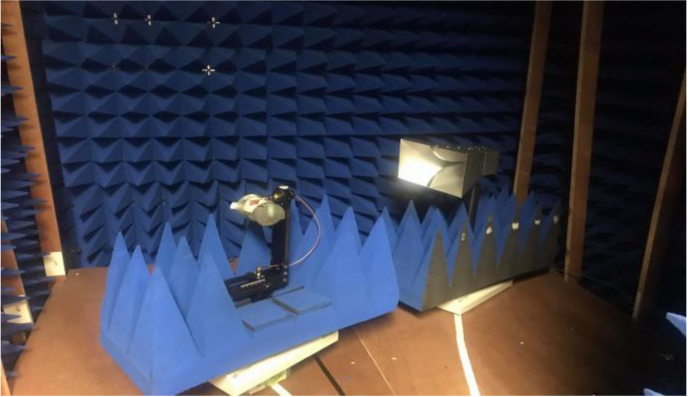
Figure 7. Antenna measurement